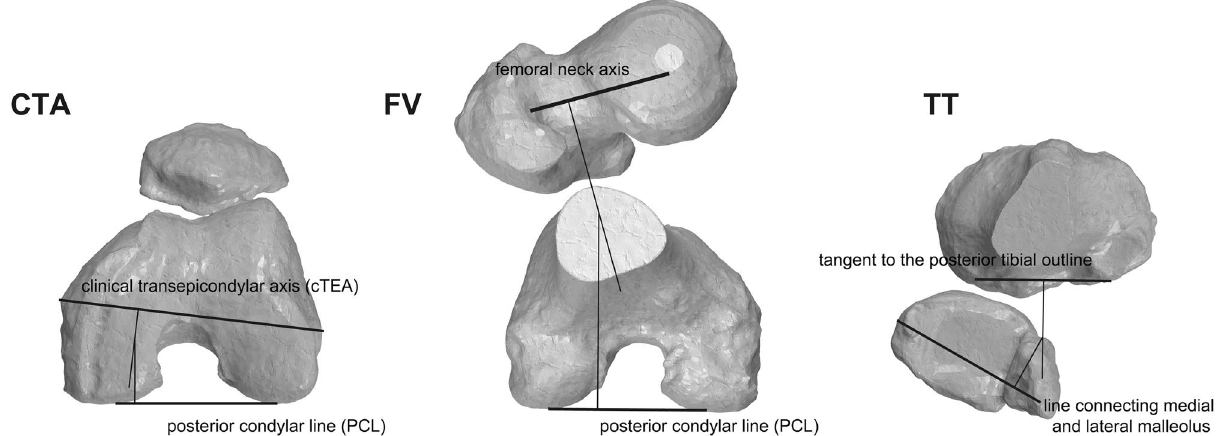
Figure 1. Anatomical references on the 3D virtual model to determine the rotational characteristics of the limb. CTA condylar twist angle: angle between the posterior condylar line and the clinical or anatomical transepicondylar axis. FV femoral version: angle between the femoral neck axis and the posterior condylar line. TT tibial torsion: angle between the line connecting the posterior cortices of the proximal tibial condyles and the line connecting the most prominent points of the medial and lateral malleolus.